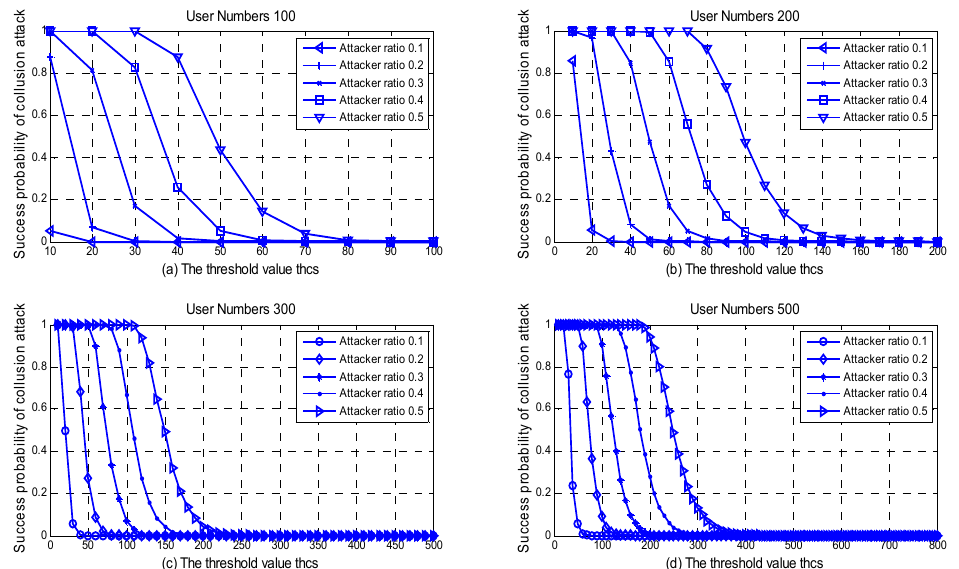
Figure 7. Collusion attacks to error revocation of the legitimate user’s public key. Panels ( a – d ) show the success probability fluctuation of this kind of collusion attack when user number is 100, 200, 300, and 500.